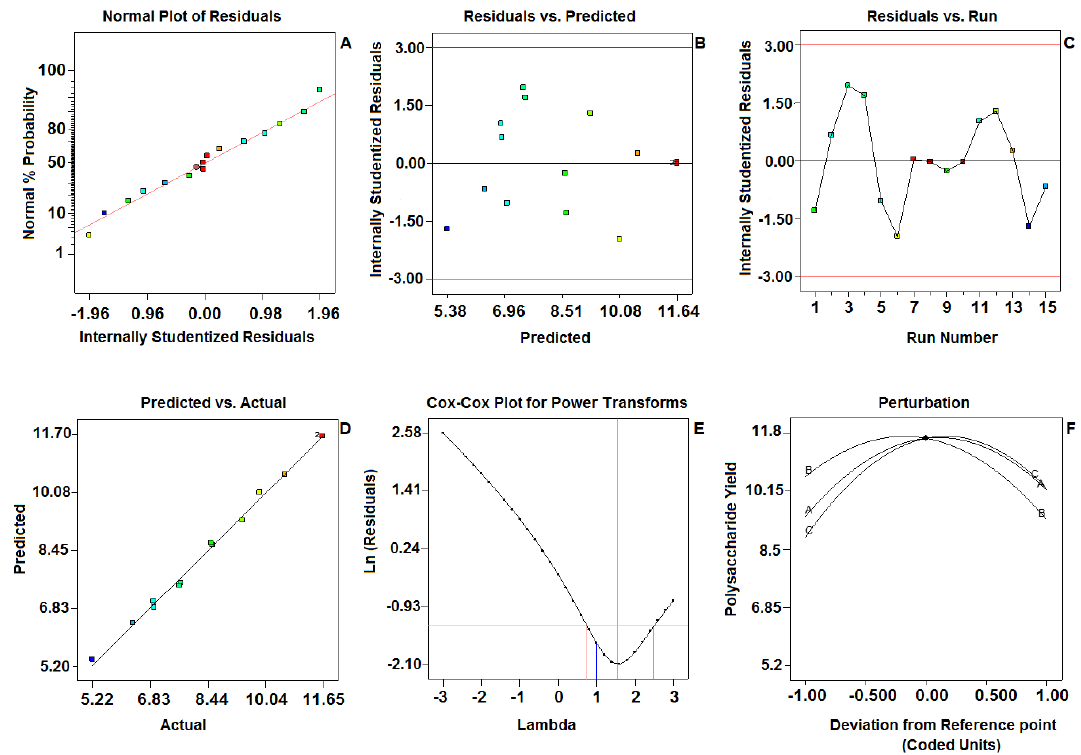
Figure 2. Diagnostic plots for the Box–Behnken model adequacy of the tested variable (predicted vs. actual) against the polysaccharide yield. ( A ) Normal plot of residuals; ( B ) Residuals vs. Predicted; ( C ) Residuals vs. Run; ( D ) Predicted vs. Actual; ( E ) Cox-Cox plot for power transforms; ( F ) Perturbation.